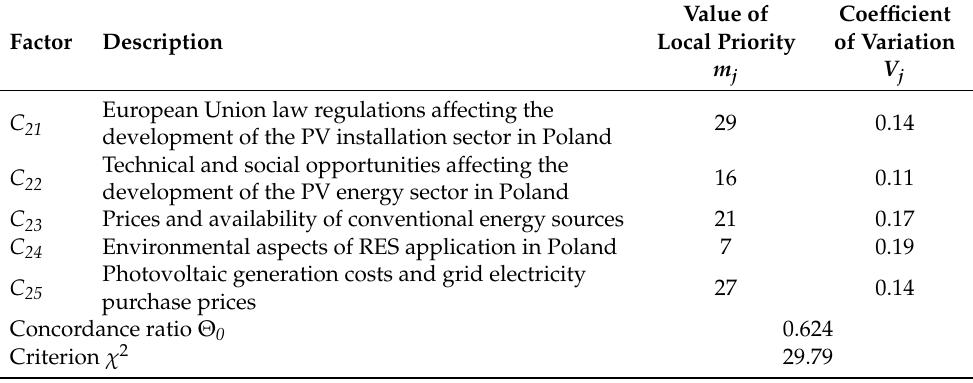
Table 2. Assessment of the importance of level II factors conditioning the development of photovoltaic power generation in Poland in the expert-mathematical method. In the presented approach, 91 experts participated in the study of possibilities of small PV systems development in Poland assessment. A research questionnaire was developed containing 9 tables into which the expert entered information on knowledge in the related field of study, ratings of the significance of levels II and III factors in the assessed group, and possible supplementary information on the given expertise. Local priorities were obtained by the sum of points provided by experts and extrapolation to the value of 100. The system priorities were calculated as a product of the local priorities from the lowest branch in the event tree (level III factors) to the level located at the top of the tree (level I) (Figure 2), with the standardization condition based on the sum of system priorities at a given level (level II or level III) equal to 100. The approach enabled the identification of the “importance” of a given factor in all sets of elements rated by the experts by the value of local priority m j (Table 2). The presented concordance coefficient at the value of 0.624 enabled the quantitative assessment of experts’ agreement and met the applied compliance criterion in expert method analysis as presented previously in the